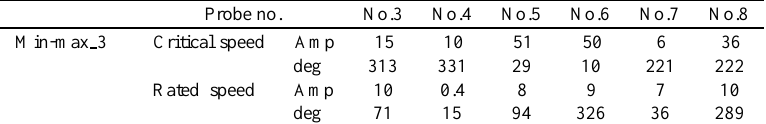
Table 8 Min-max 3 final vibration with the response constraint and weight splitting